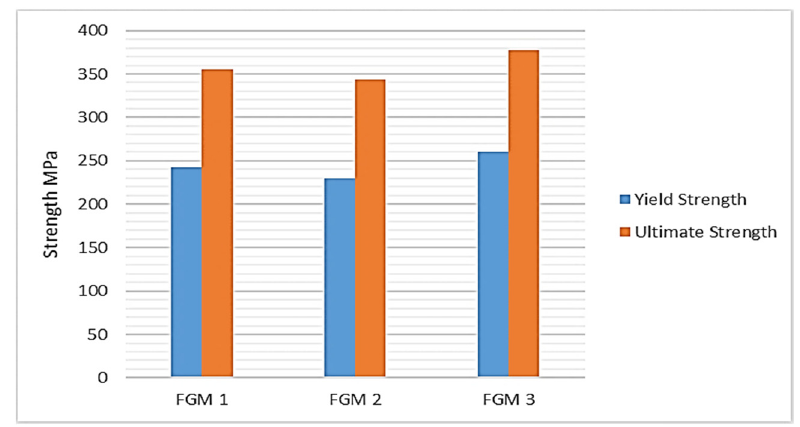
Figure 13: Yield and ultimate strength for each